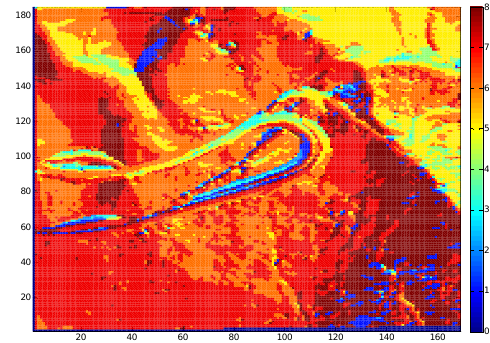
Figure 11. Runoff directions from a raster with a grid size of 3 m from an original point